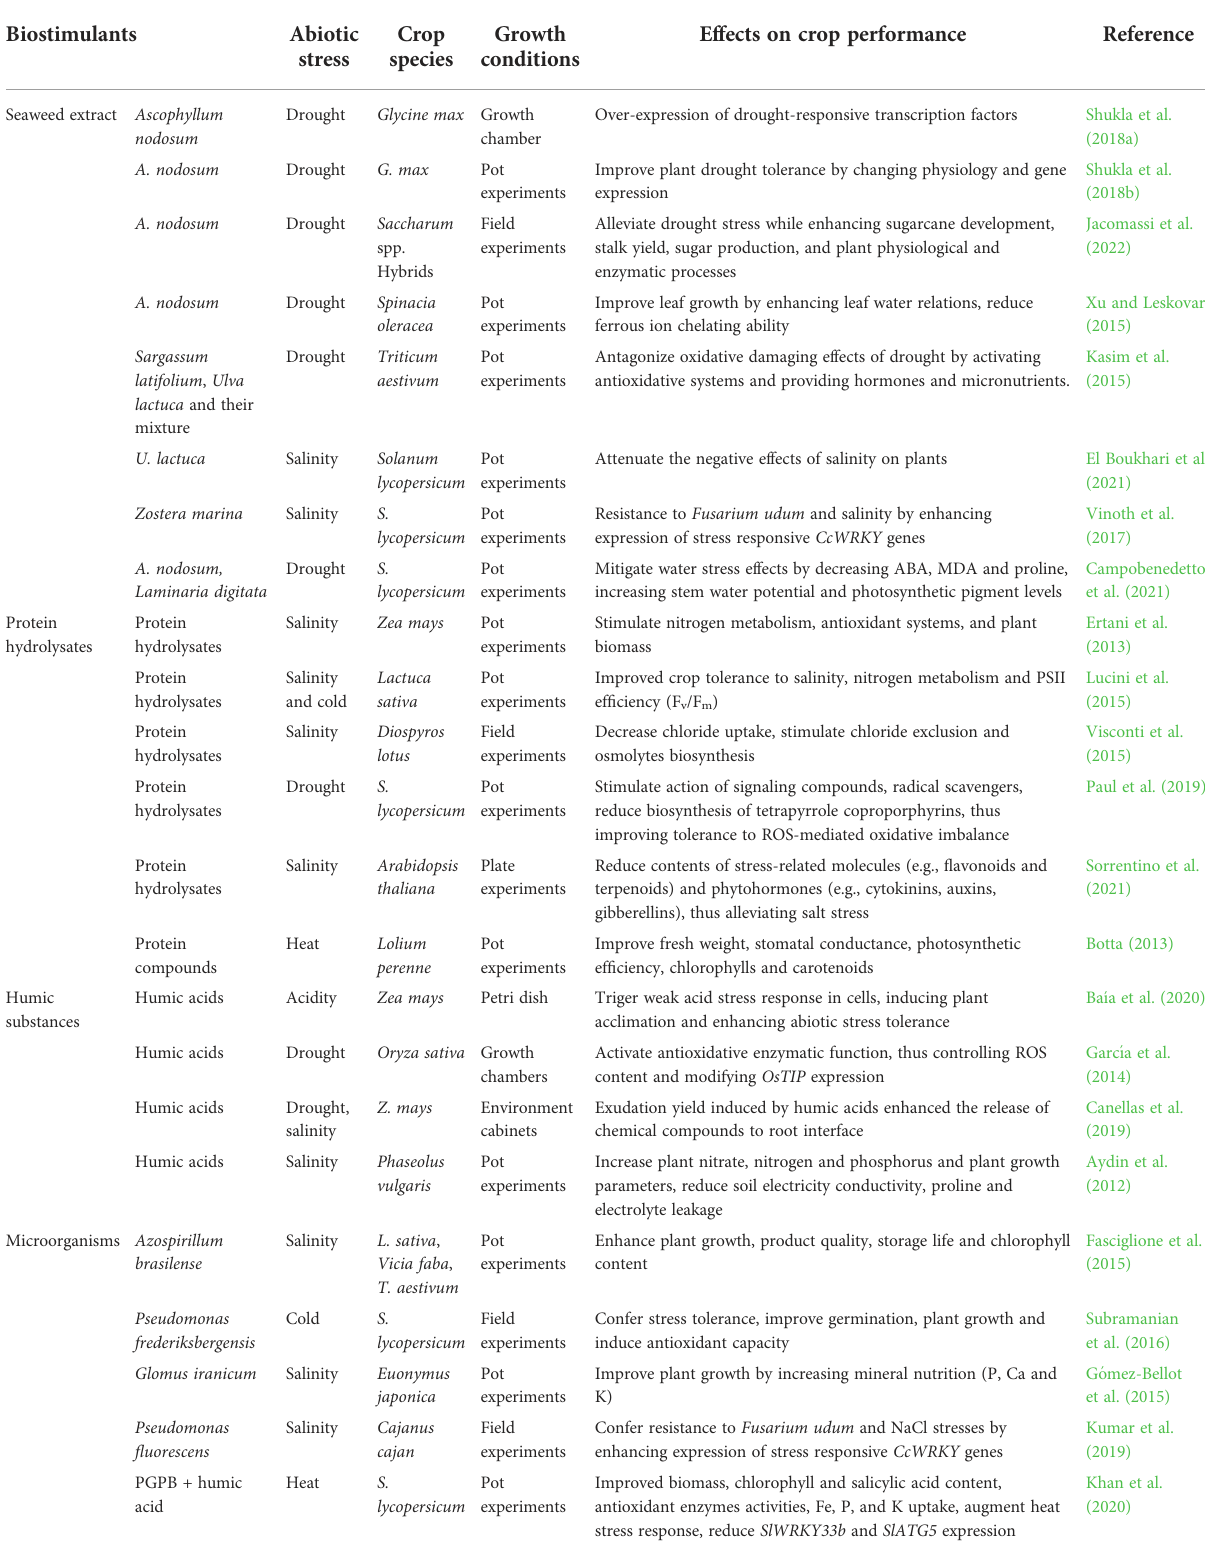
TABLE 2 From lab to fi eld implementation of biostimulants in crop production.